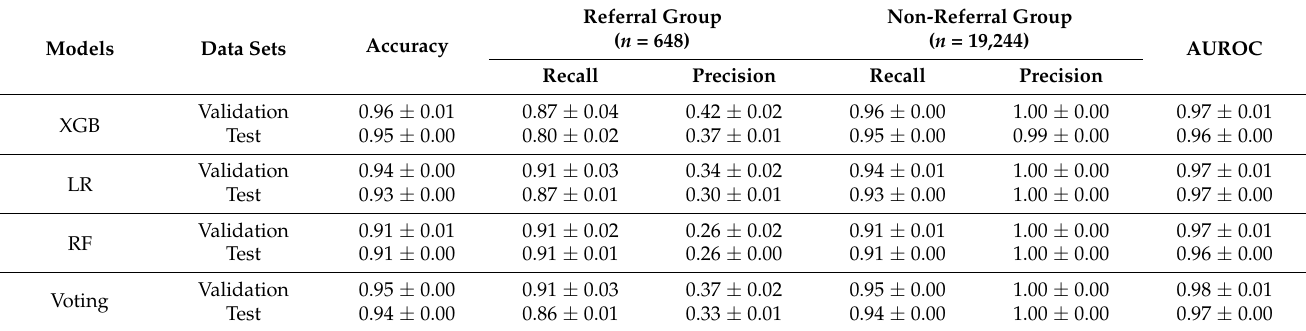
Table 2. Performance metrics for the three models to predict rapidly progressive kidney disease